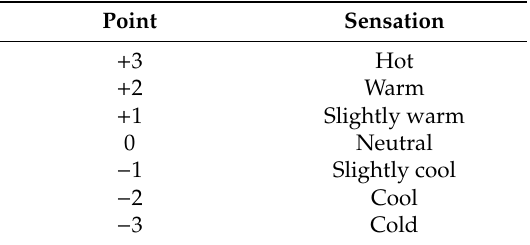
Table 2. Seven-point thermal sensation scale